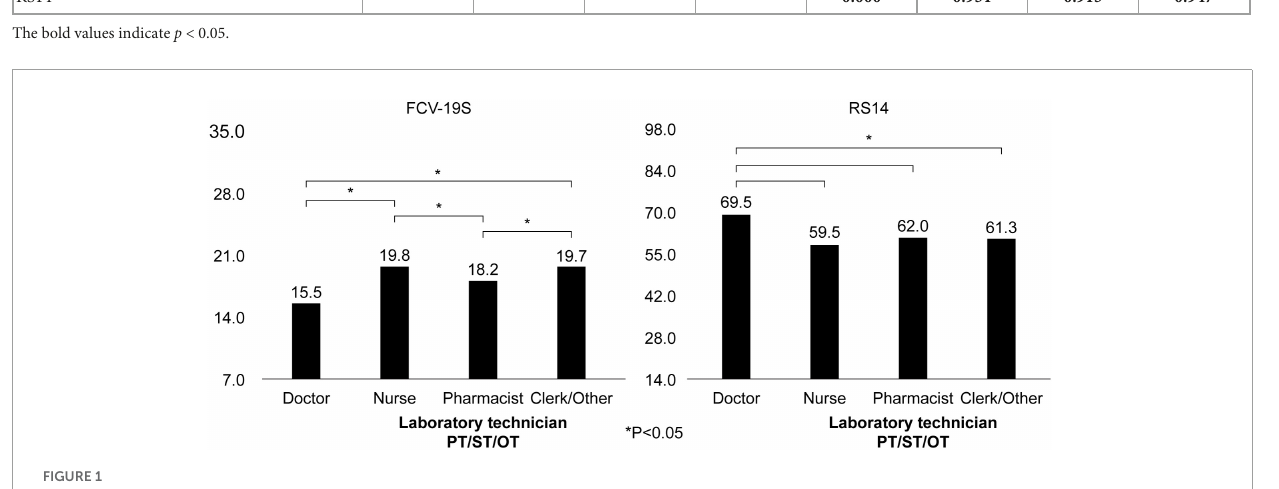
FIGURE1 FCV-19S and RS14 in each occupation.